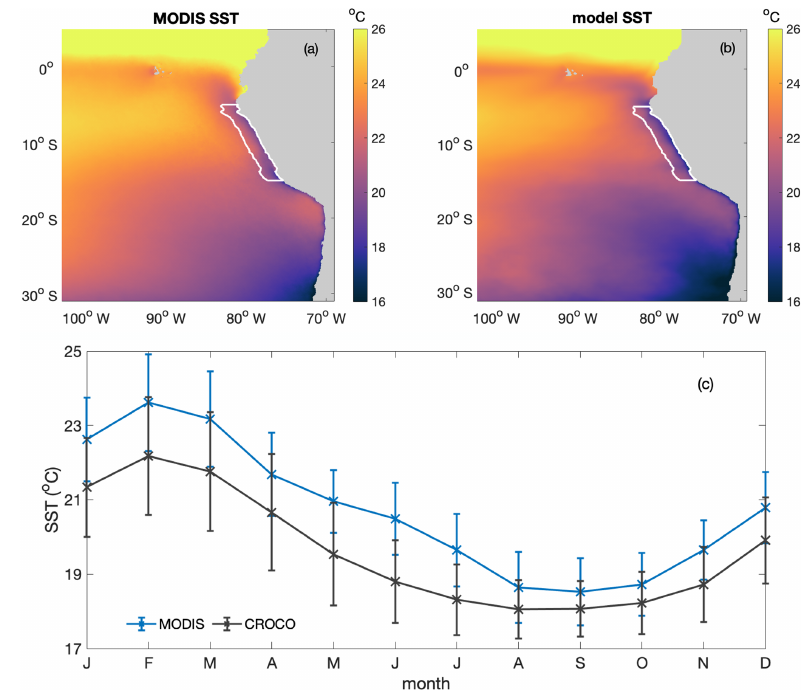
Figure B4. Annual average spatial distribution of sea surface temperature (SST; in degrees Celsius) from (a) MODIS and (b) CROCO– BioEBUS, (c) seasonal variation in average sea surface temperature from MODIS (cross) and model simulation (line) within the focus region. White lines highlight the focus